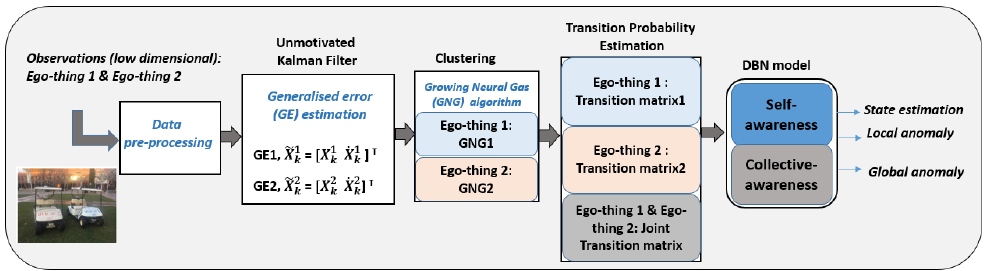
Figure 1. Dynamic Bayesian network (DBN) model learning